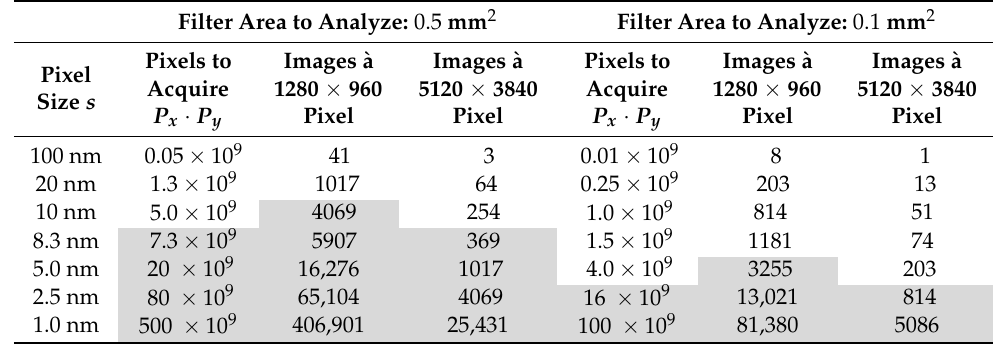
Table 4. Number of pixels and images to acquire for analyzing 0.5 mm 2 or 0.5 mm 2 /5 = 0.1 mm 2 filter area. Image numbers of currently hardly or not yet manageable workloads are marked in